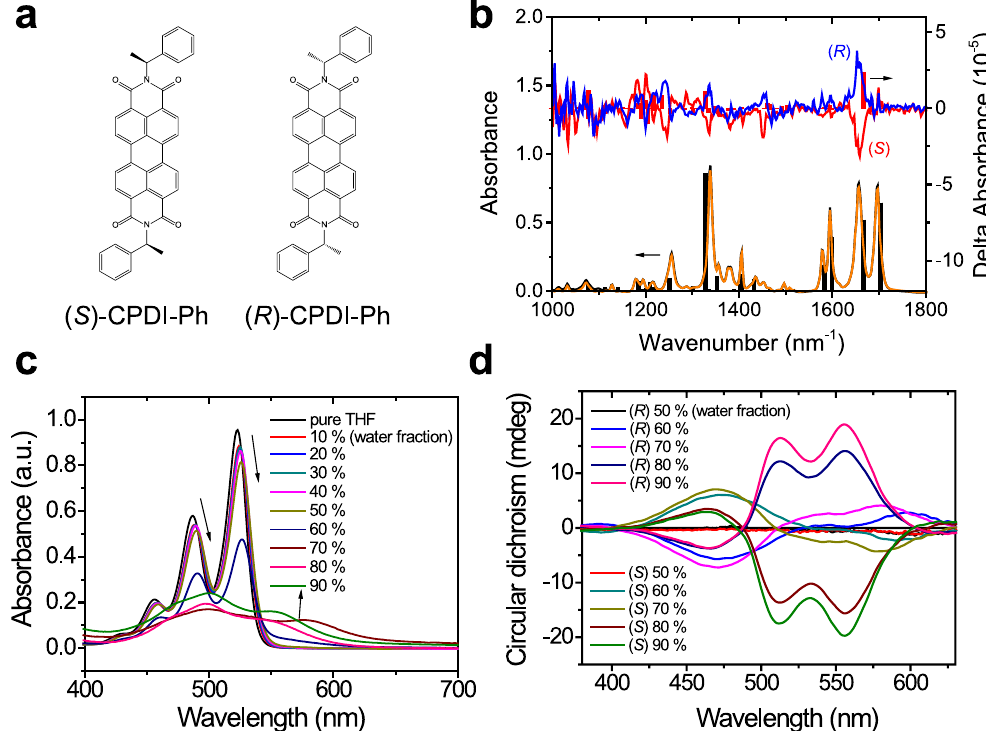
Figure 1. ( a ) Molecular structures of ( S )-CPDI-Ph and ( R )-CPDI-Ph. ( b ) Experiment and Calculation results of IR and VCD spectra of CPDI-Ph. Solid lines show experiment data of CPDI-Ph and blocks show calculation results for ( R )-CPDI-Ph. ( c ) UV-vis spectra of ( S )-CPDI-Ph and ( d ) CD spectra of enantiomeric CPDI-Ph in THF/water mixed solution (1.0 × 10 − 5 M) with different f w